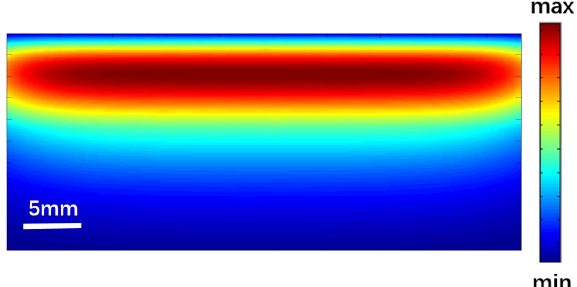
Fig. 3. (cid:2) Map of the central cut